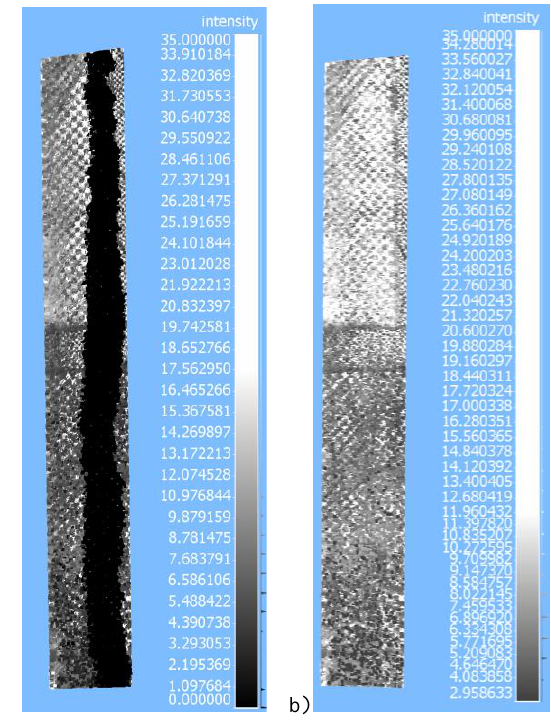
Figure 5 . Test data acquired with Livox Avia sensor inside the building: with the noisy points (a) and with noisy points filtered